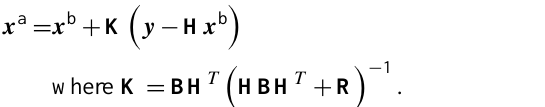
Figure 4. Comparison of CO analyses obtained by the assimilation of MOPITT V3 CO total column observations with the optimal error estimated by the χ 2 test ( a and b ) to the operational MOPITT V3 CO retrieved profiles ( c and d ) at 700hPa (left panels) and 250hPa (right panels). The corresponding relative differences between both data sets (TOTCOL_ANALYSES – observations) are indicated in the bottom panels for both pressure levels ( e for 700hPa and (f) for 250hPa). Blue and red colours indicate negative and positive differences, respectively. Note that this figure corresponds to an average over August 2008 for all observations carried out over land and sea during daytime and nighttime.